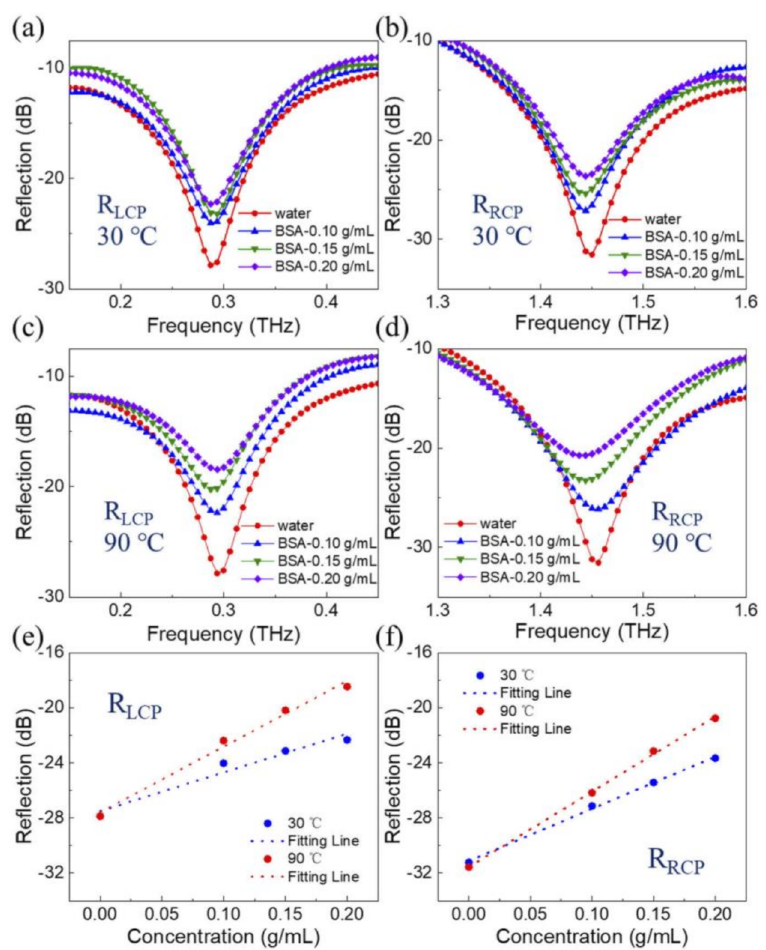
Figure 7. Sensing results of the BSA solution with different concentrations. ( a ) LCP spectra R LCP and ( b ) R RCP at 30 ◦ C. ( c ) R LCP and ( d ) R RCP at 90 ◦ C. The peak value ( e ) R LCP and ( f ) R RCP of BSA solution change with sample concentration. Reprinted from Ref.